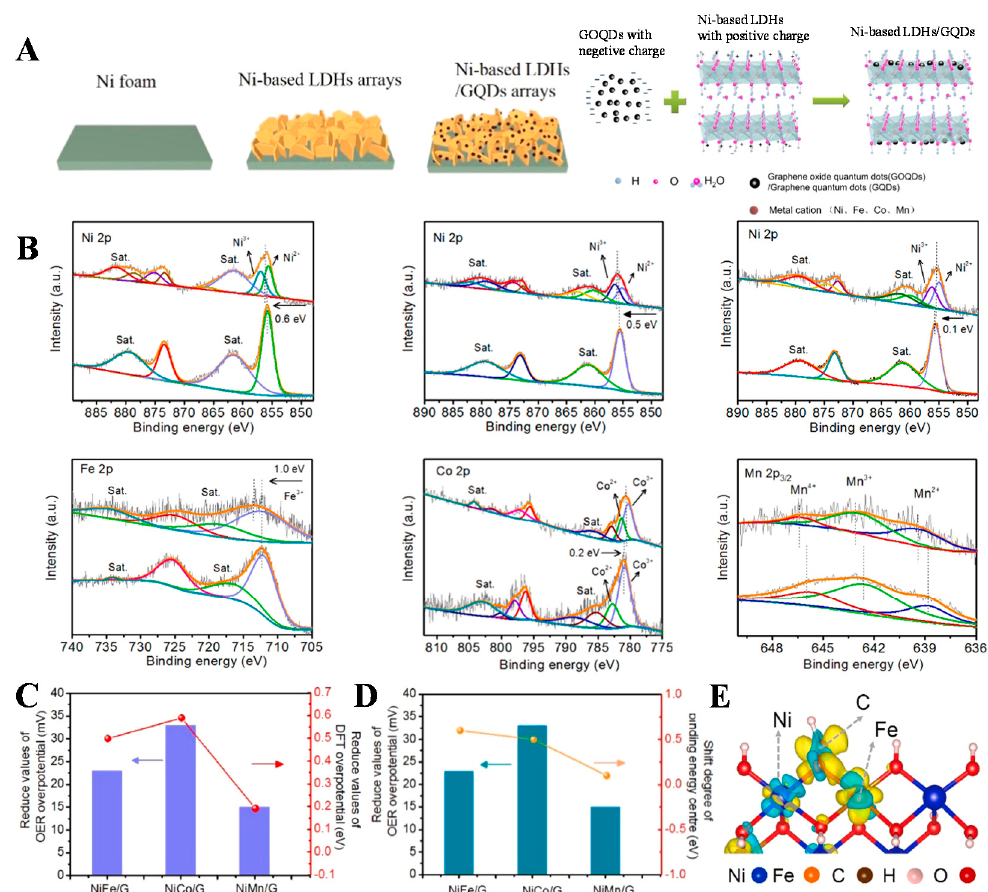
Figure 12. ( A ) Schematic illustration of the fabrication and synthesis principle of the Ni-based LDH/GQDs nanosheet arrays; ( B ) XPS spectra of the NiFe-LDHs/GQD (left), NiCo-LDHs/GQD (middle), NiMn-LDHs/GQD (right) electrocatalysts, respectively; ( C ) Reduced LSV overpotentials at 10mAcm − 2 vs. shift degree of Ni 2 p 3/2 binding energy center for Ni-based LDHs/GQDs; ( D ) Reduced LSV overpotentials at 10mAcm − 2 vs. reduced DFT overpotentials of Ni-based LDHs/GQDs; ( E ) Charge density difference of NiFe/G when O-CH bonds with Ni/Fe (iso-surface levels are 0.0036 eÅ − 3 , cyan and yellow represented electron depletion and accumulation, respectively) [178]. Copyright © 2021 Elsevier Ltd.